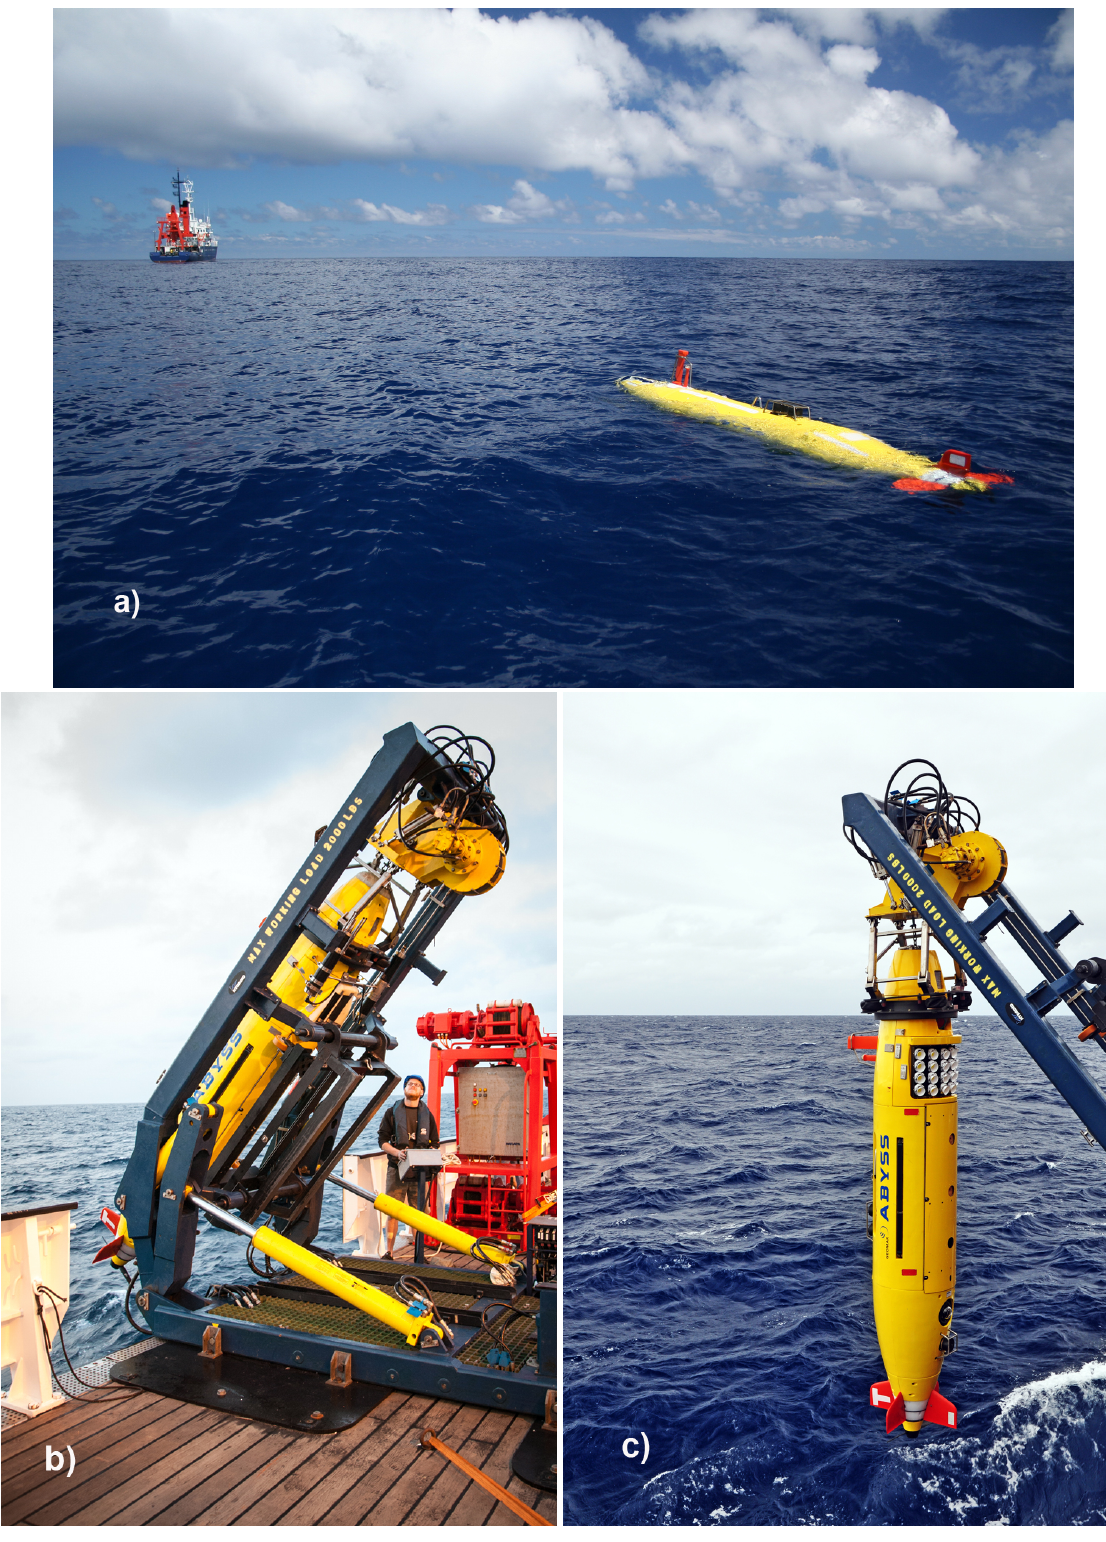
Figure 1: AUV “ABYSS“, a) at the sea surface approaching the German research vessel “POSEIDON” for recovery, b) deployed with its launch and recovery system, c) novel LED flash system in the front and the camera behind a dome port in the tail section of the